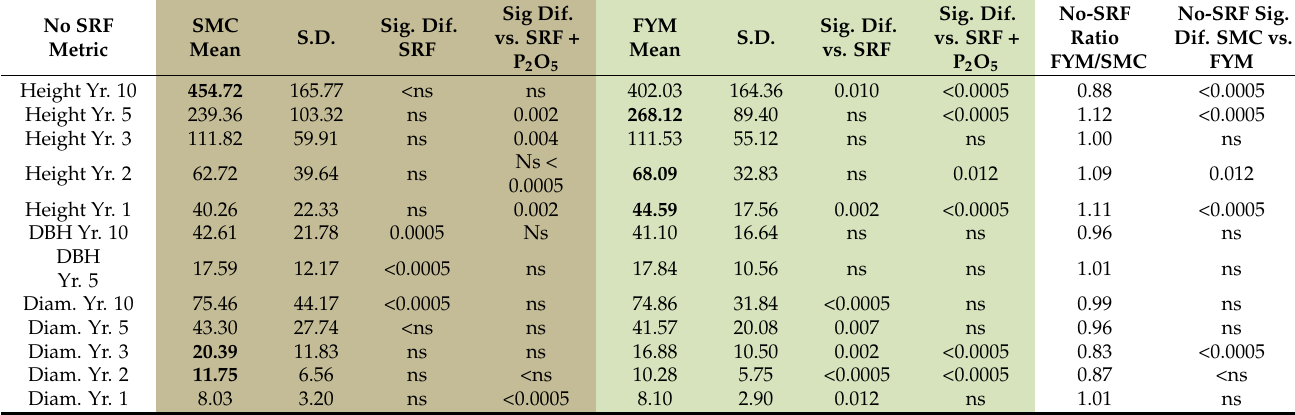
Table 7. Comparison of SMC- and FYM-planted trees given no additional fertilizer (no SRF). (Nb: Yr.: Year of record; height (cm); DBH (mm); Diam. Diameter above the root collar (mm), Sig. significant difference p =; leader in SMC or FYM categories emboldened). No SRF Metric Height Yr.